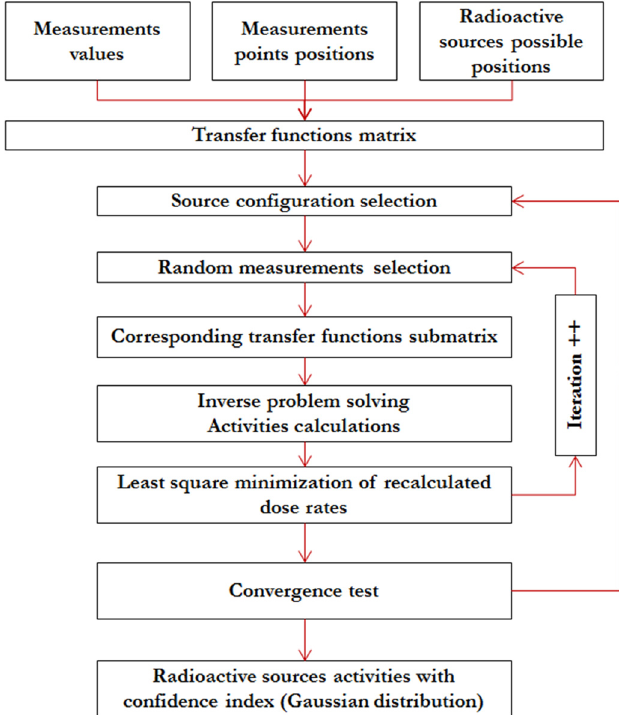
Fig. 14. Minimization method